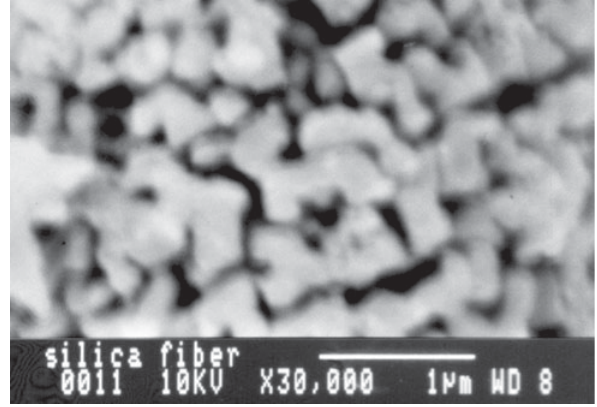
Figure 3. SEM microscopy in the fiber surface after removal of metal phase by HCl immersion, showing arms width of about 0.25 µ